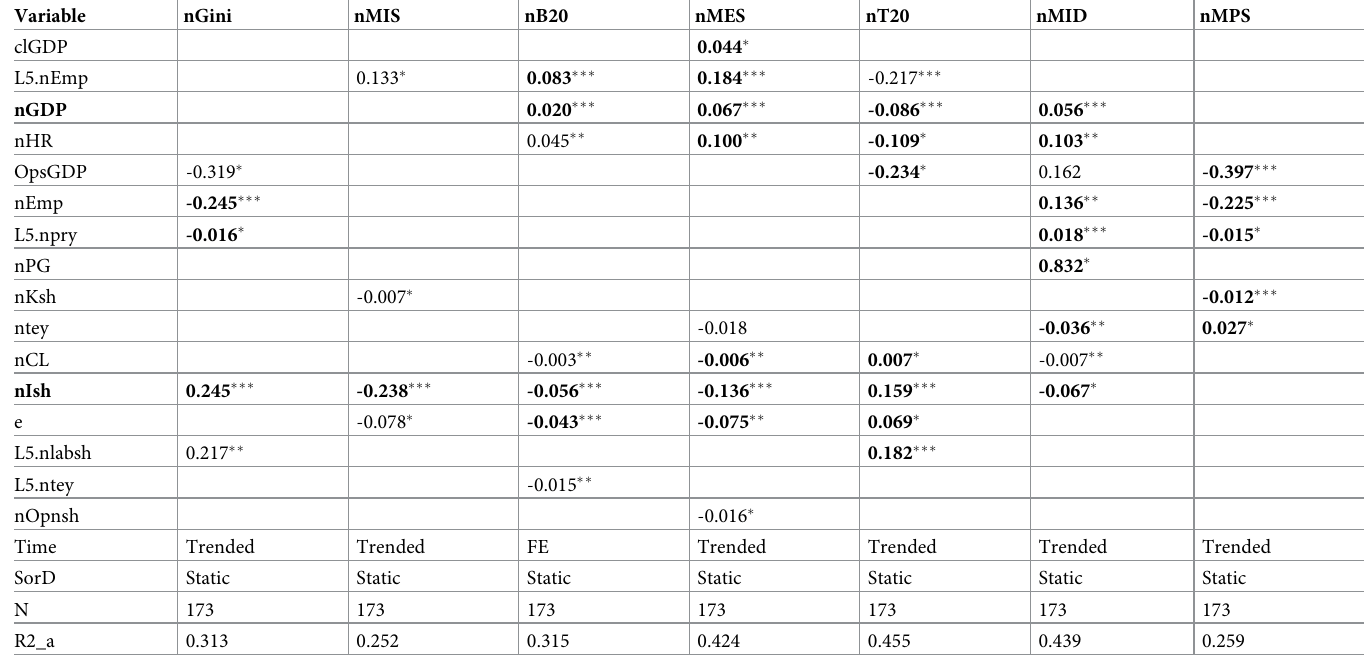
Table 15. Robust determinants of income distribution across